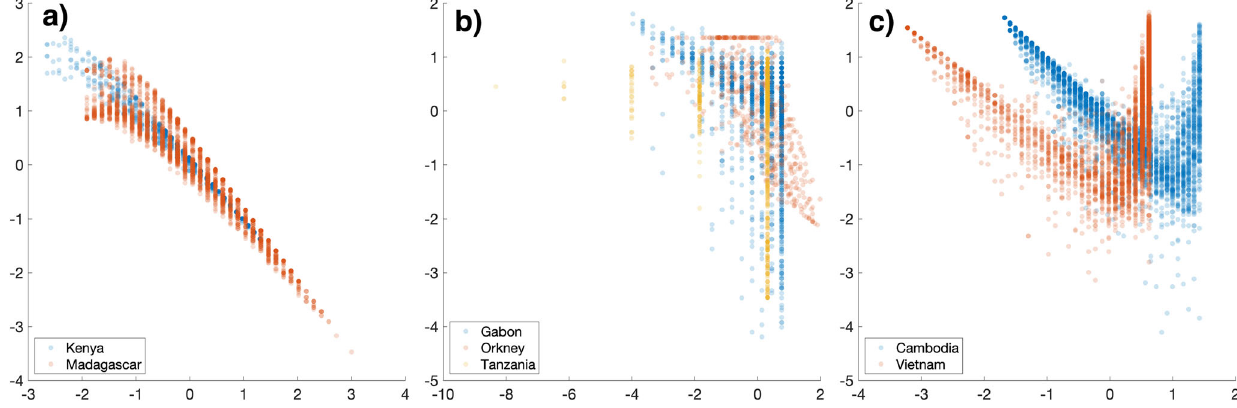
Fig. 2 Environment (x-axis) vs. Production (y-axis) scores across game datasets (as Z-scores, standardized at country-game level — all variables have a mean of 0 at the level of country-game). a SharedSpace; b GooseBump (Orkney — Geese; Gabon — Elephants; Tanzania — Lions); c